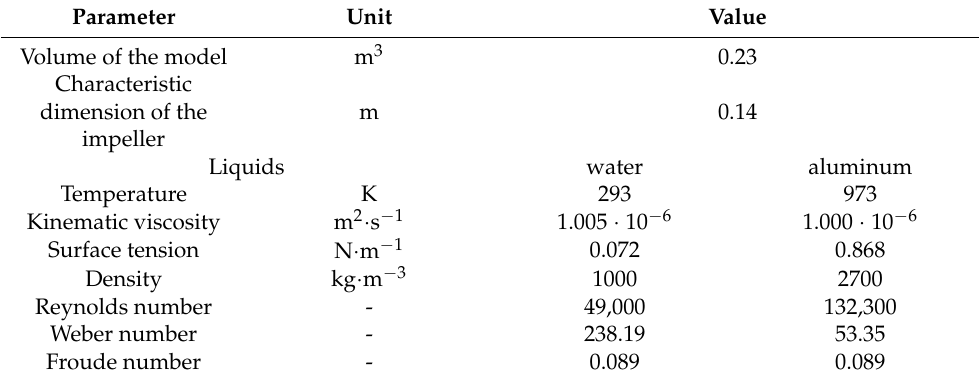
Figure 1. ( a ) View of the URO-200 model; ( b ) scheme model with marked places of fixed measuring sensors and the most important dimensions (in m). Table 1. Comparison of the basic physical parameters and criterion numbers [33,35].